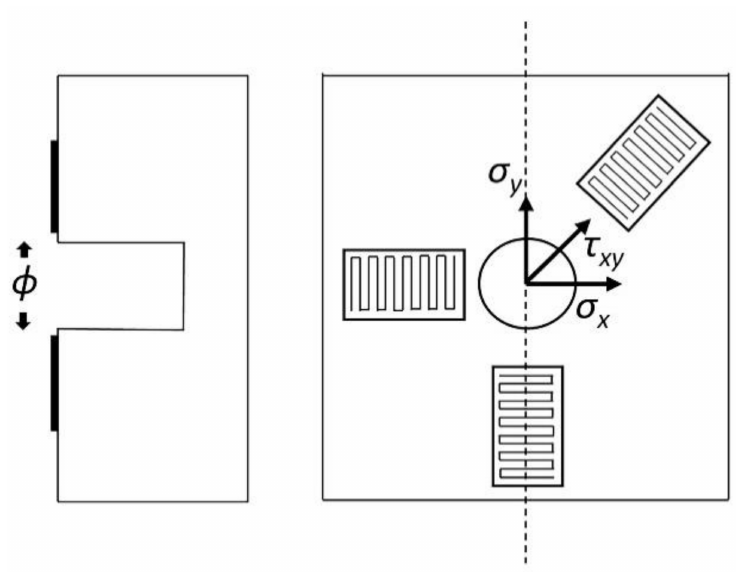
Figure 3. Schematic of the incremental centre hole-drilling technique